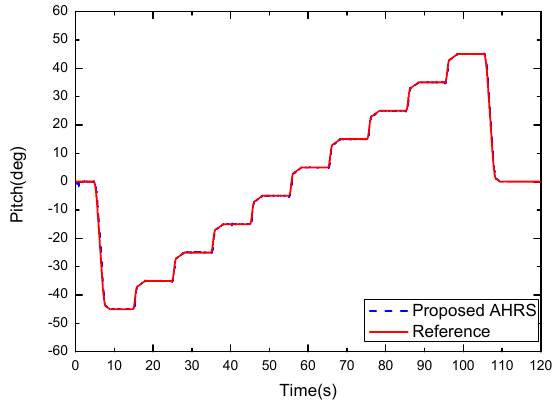
Figure 10. Pitch estimate produced by the proposed Kalman filter (blue dash curve, µ a = 0.9) and the turntable reference(red solid curve).